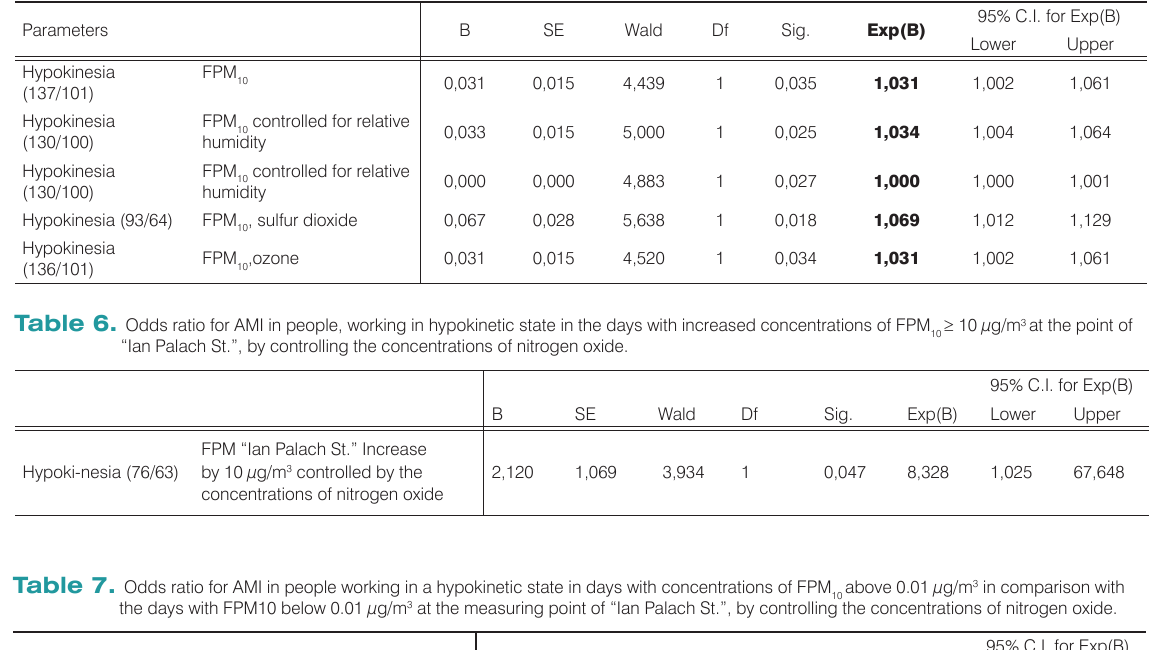
Table 5. Odds ratio for AMI in people working in hypokinetic state, according to the mean 24-hour value of FPM in an independent, combined with ozone and sulfur dioxide, and with relative humidity action. Parameters